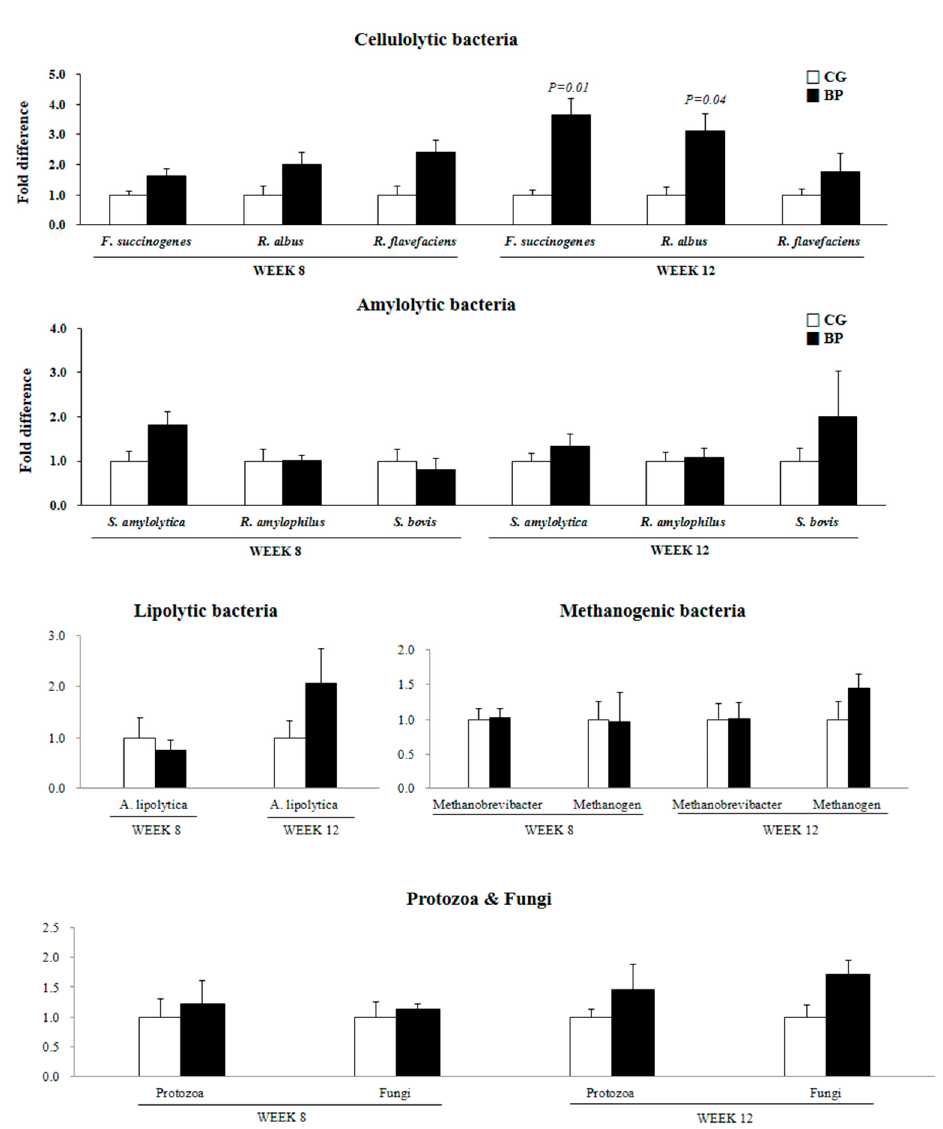
Figure 1. Effects of feeding corn grain (CG) or beet pulp (BP) on the ruminal population of cellulolytic bacteria, amylolytic bacteria, lipolytic bacteria, methanogens, total protozoa, and total fungi in Korean cattle steers. The microbial population was measured by quantitative real-time polymerase chain reaction using the total bacterial 16S rRNA gene as the reference gene. Fold difference of the CG group value of each bacterium for each week was normalized to 1.0-fold. Values are fold difference + standard error: F. succinogenes = Fibrobacter succinogenes ; R. albus = Ruminococcus albus ; R. flavefaciens = Ruminococcus flavefaciens ; S. amylolytica = Succinimonas amylolytica ; R. amylophilus = Ruminobacter amylophilus ; S. bovis = Streptococcus bovis ; A. lipolytica = Anaerovibrio lipolytica . Microbial population was not different ( p > 0.05) if no p- value indicated.